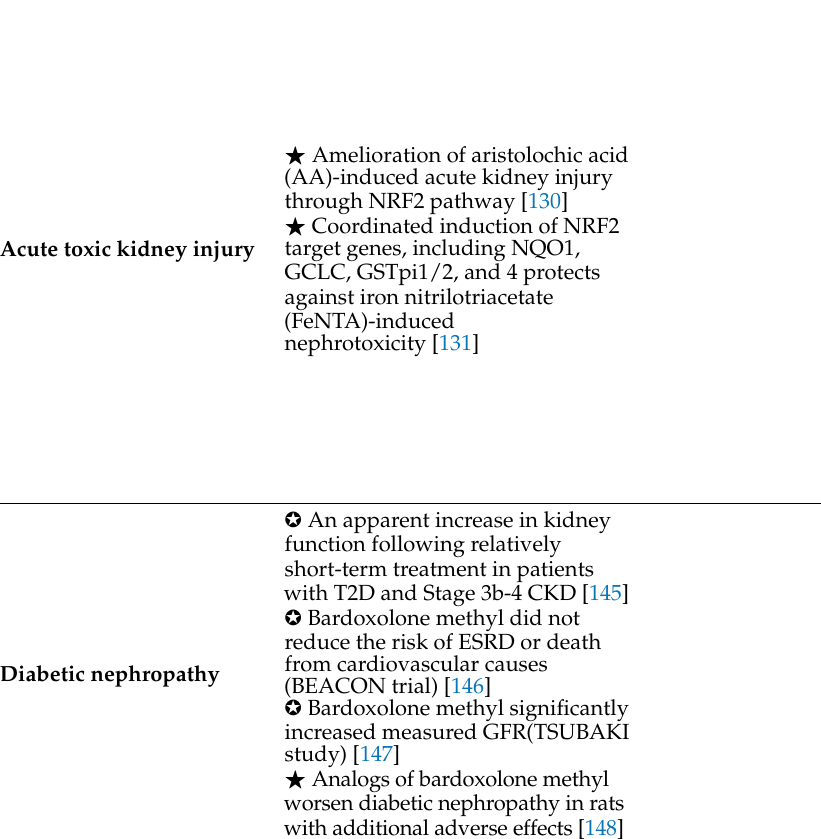
Bardoxolone Methyl (BARD-Me) and Associated